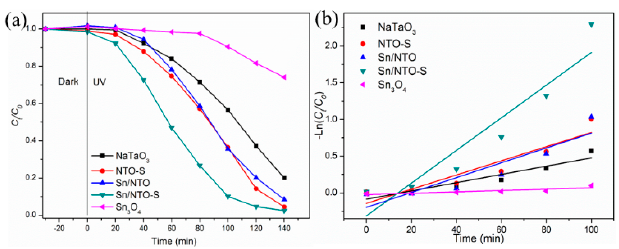
Figure 5. Photocatalytic degradation activities ( a ) and plots ( b ) of –Ln (C t /C 0 ) vs. irradiation time for RhB degradation under ultraviolet light irradiation, measured at regular time intervals in the presence of NaTaO 3 , NTO-S, Sn/NTO, Sn/NTO-S, and Sn 3 O 4, respectively.